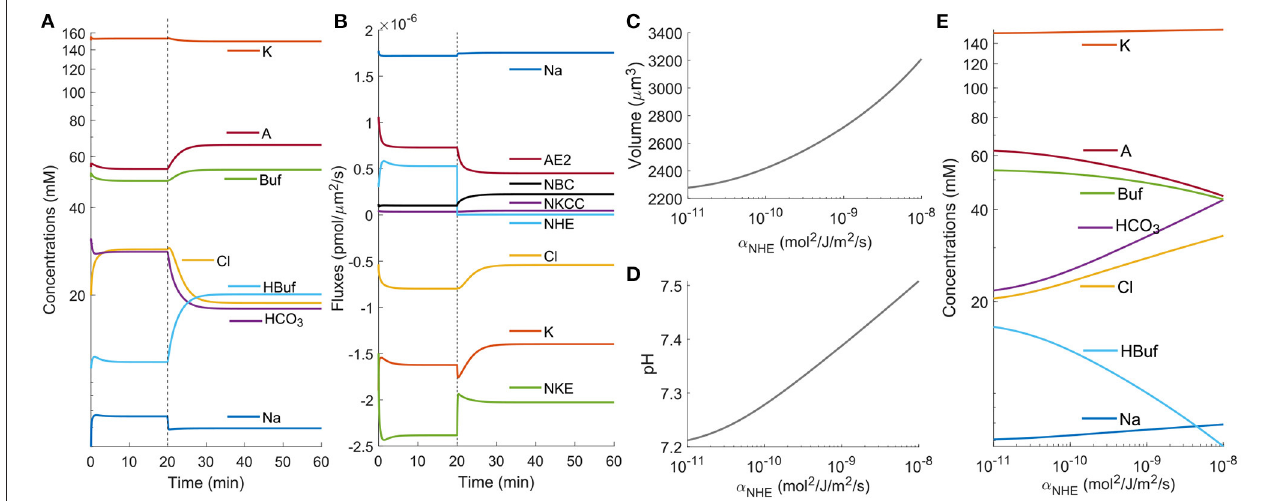
FIGURE 3 | Model predictions of the cellular response upon NHE inhibition. (A) Intracellular ion concentrations upon NHE inhibition at t 0 = 20 min. (B) Ion fluxes across each channel and co-transporter upon NHE inhibition at t 0 = 20 min. (C) Model prediction of the cell volume when NHE is inhibited. (D) Model prediction of the intracellular pH when NHE is inhibited. (E) Model prediction of the intracellular ion concentrations when NHE is